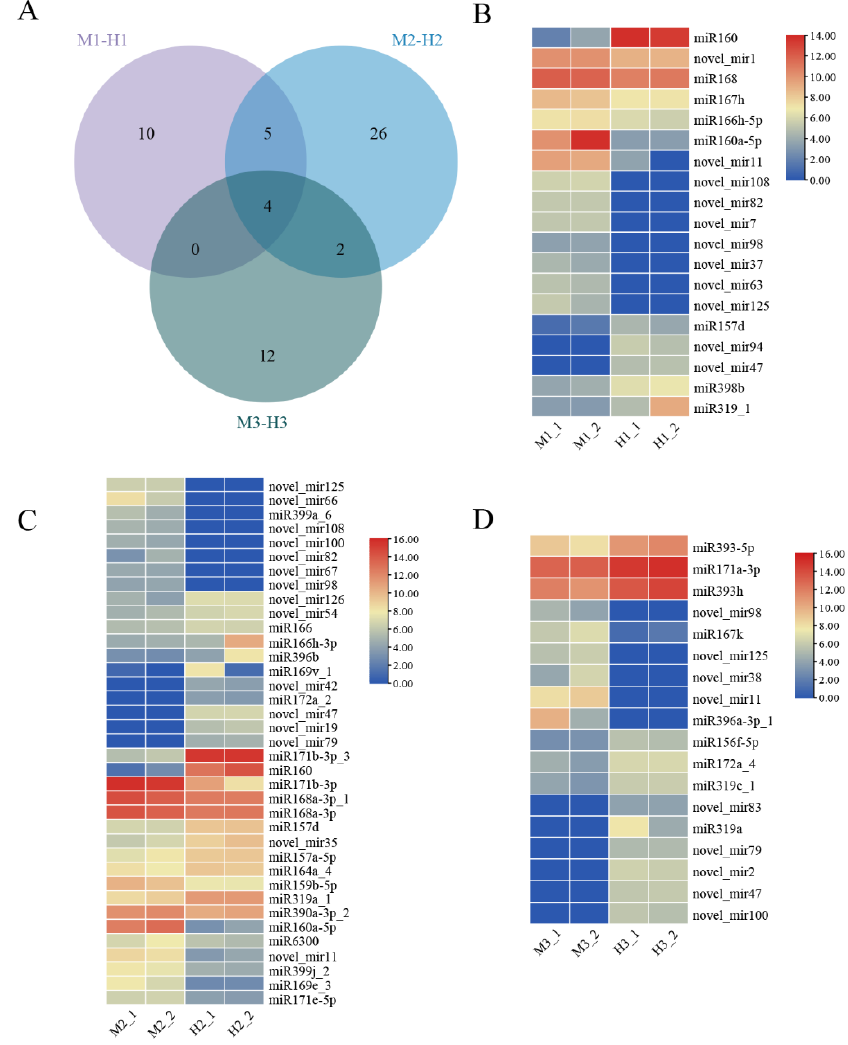
Figure 2. Localization of miRNAs on chromosomes and family analysis of conserved miRNAs. ( A ) Localization of identified miRNAs on the chromosomes. Orange and blue fonts indicate the known mature miRNAs and novel miRNAs, respectively. ( B ) The 40 families of conserved miR- NAs.